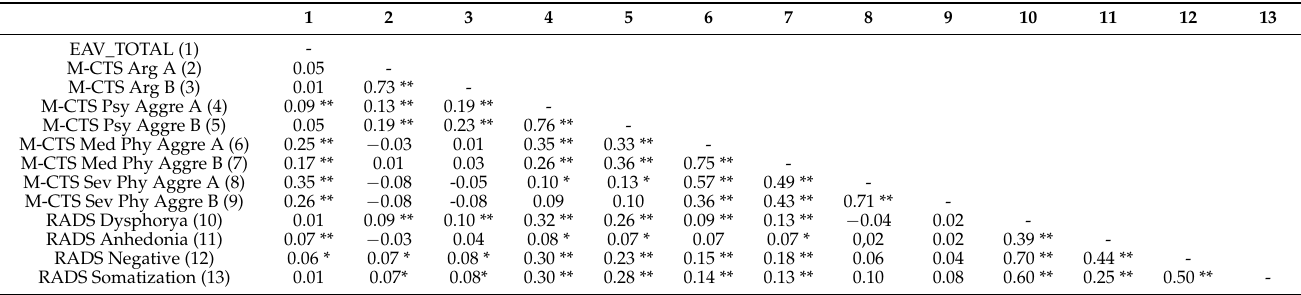
Table 5. Pearson’s Correlations between the Attitudes Scale Towards Violence (EAV), the Modified Conflict Tactics Scale (MCTS), and the Reynolds (RADS)